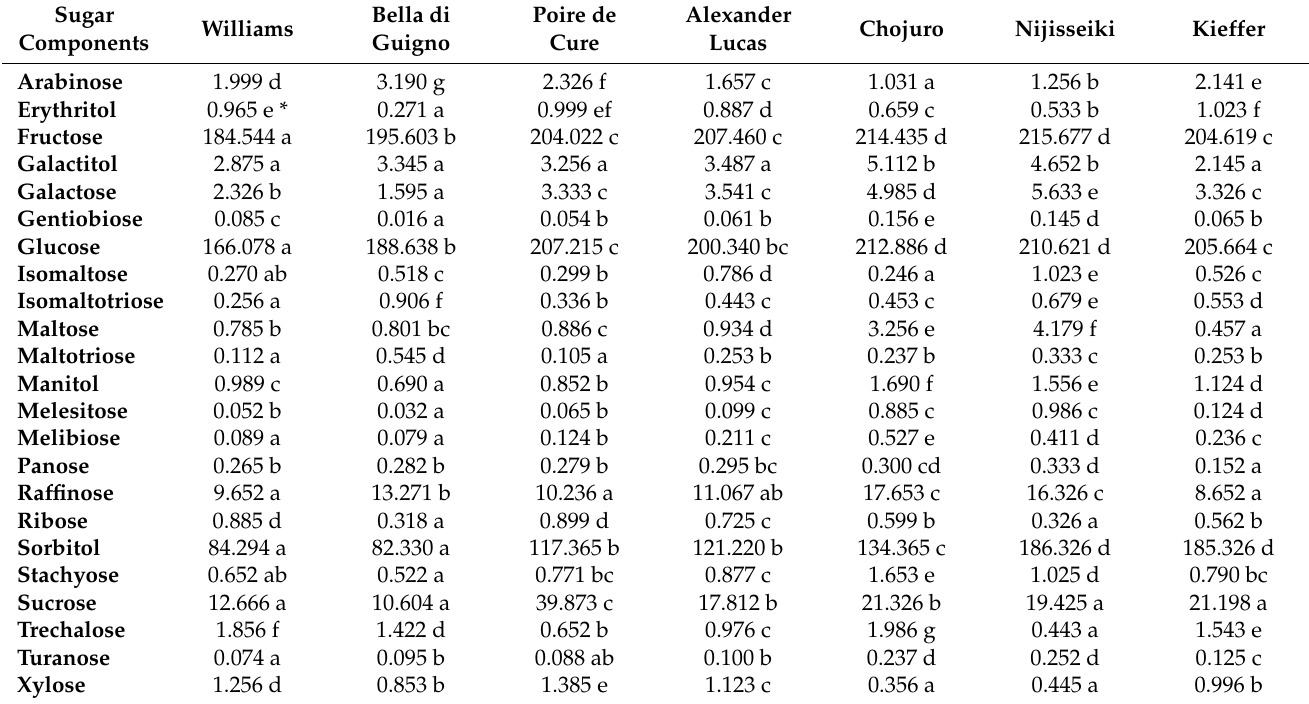
Table 2. The average content of individual sugars (mg/g) in nectar of seven Pyrus